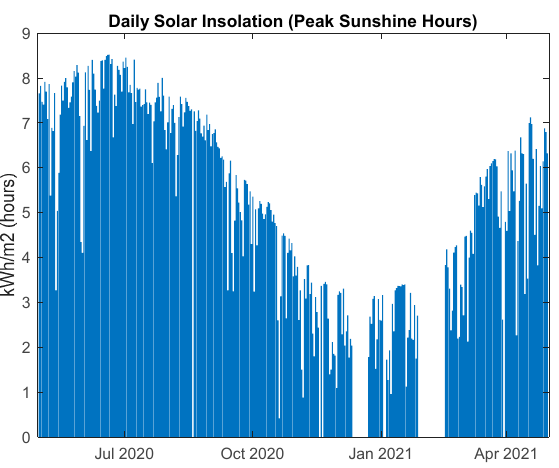
Figure 3. Annual Daily Solar Insolation.